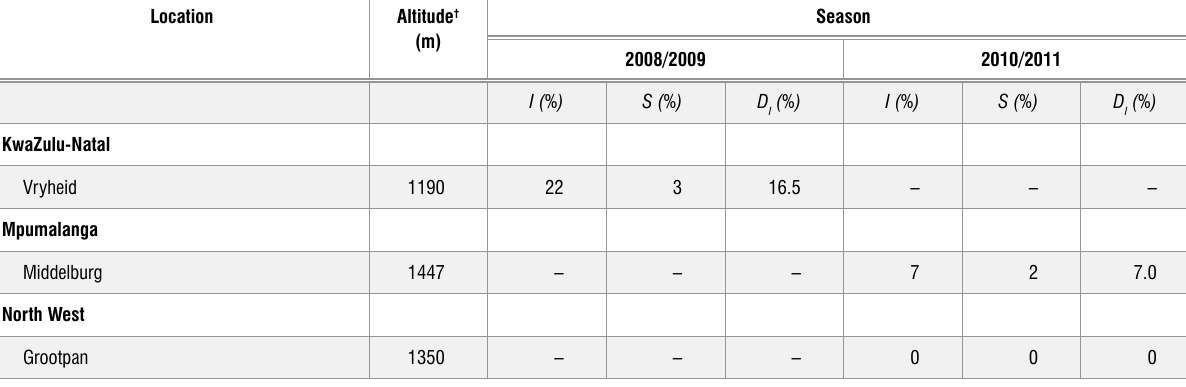
Occurrence of bacterial brown spot in dry bean strip trials of South Africa